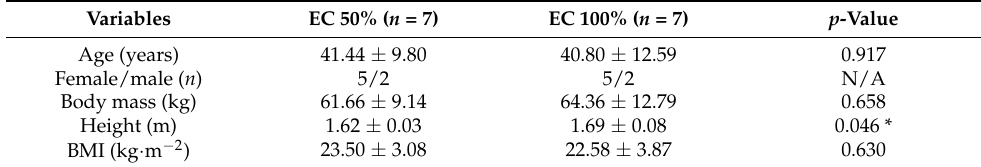
Table 3. Characteristics of the